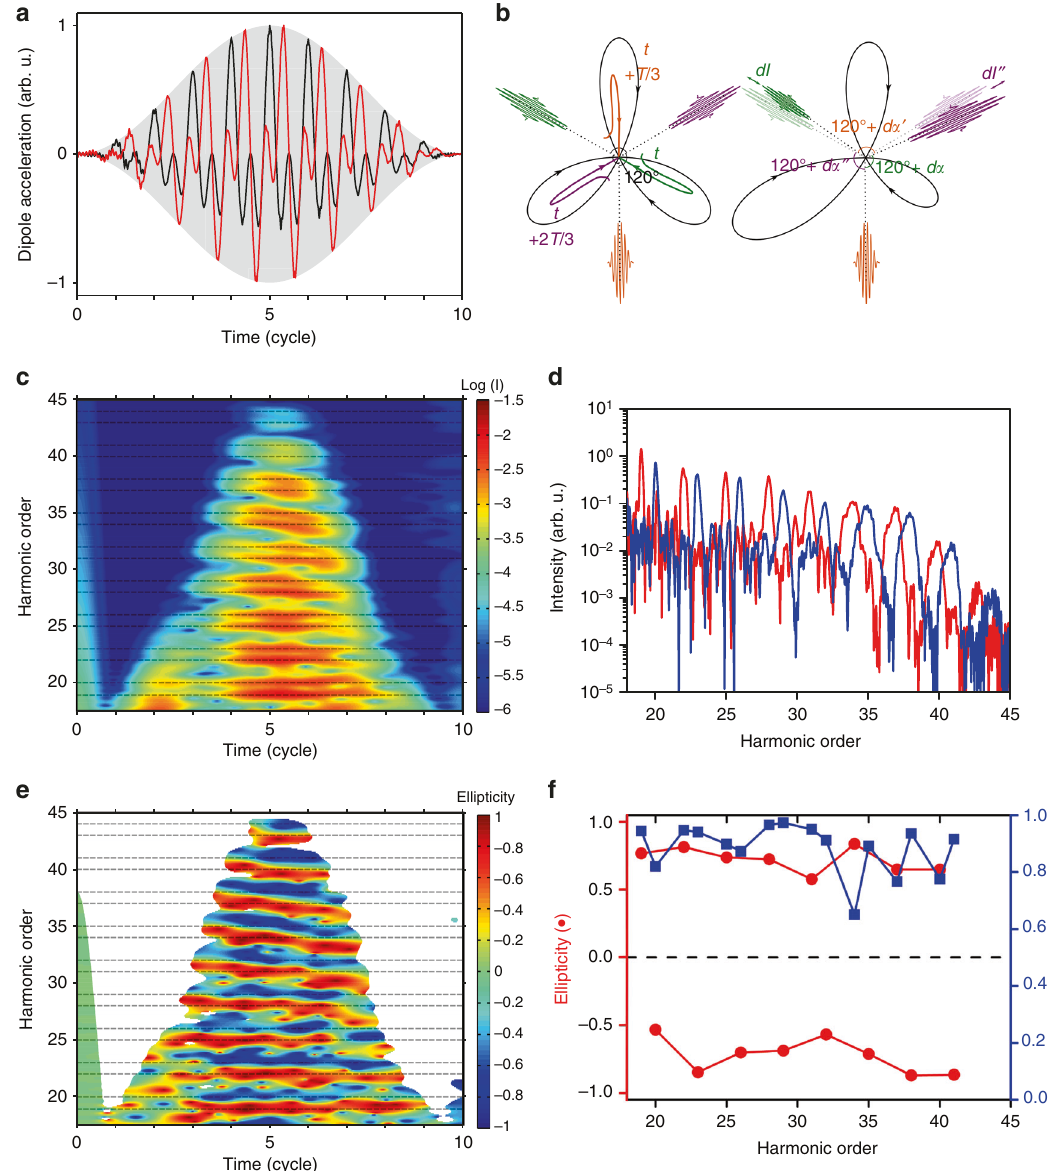
Fig. 1 Short-pulse envelope effects in helium. a Dipole acceleration along the x and y components resulting from the interaction of a helium atom with 800- and 400-nm pulses (sin² envelope with 5 ω -cycle full-width-at-half-maximum (FWHM) duration, shaded gray) at I ω = I 2 ω = 2 × 10 14 W/cm². b Illustration of the harmonic generation process for a constant laser envelope (left) and on a short-pulse leading edge (right). Typical electron trajectories 24 launched every T /3 of the total driving fi eld (black) are shown in lines of different colors together with the corresponding attosecond pulses emitted at recollision. c Time-frequency representation of the harmonic intensity, in logarithmic scale, obtained after Gabor transformation of the dipole shown in ( a ) with a temporal Gaussian window of one- ω -cycle FWHM. d Corresponding harmonic spectra for the components co-rotating (red) or counter-rotating (blue) with the ω fi eld. e Time-frequency representation of the harmonic ellipticity, showing the alternating helicity of the 3 q + 1 and 3 q + 2 harmonics. f Ellipticity and degree of polarization calculated over the harmonic spectral width ( + / − 0.25 order until H32 and + / − 0.5 order for higher